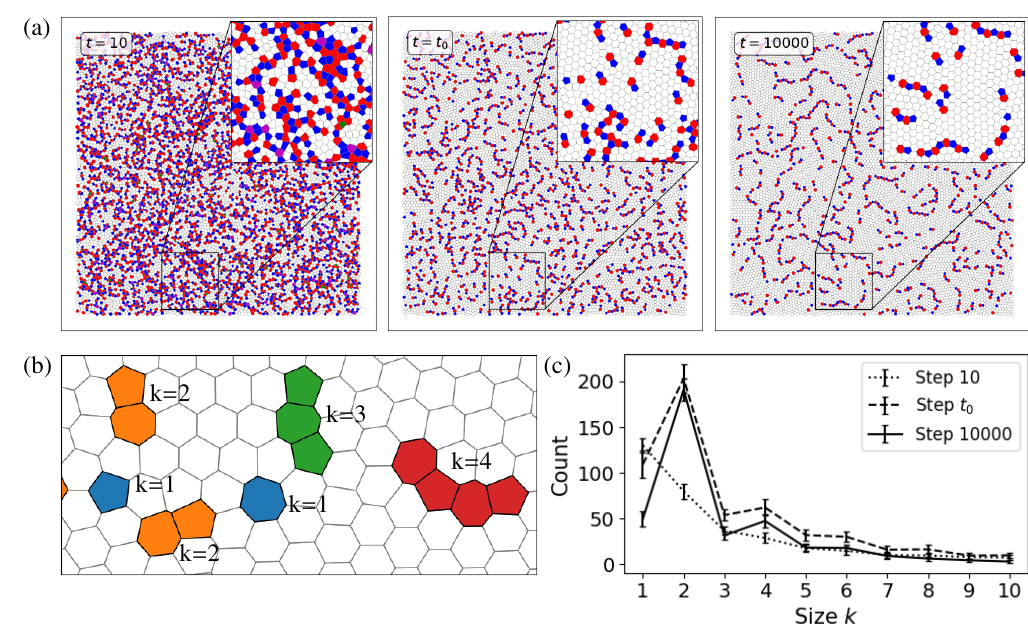
Figure 2: (a) Voronoi landscapes of an evolving Poisson-PP at Lloyd steps t = 10 , t 0 and 10 4 (from left to right), where cells are coloured according to the number of their edges; in particular, pentagons and heptagons are highlighted in blue and red, respectively, while hexagons are white. The inset shows a zoom-in window for the same selected area in each snapshot. (b) An illustration of defect components in di ff erent colours according to their size k , captured in a local area of the rightmost configuration in (a). (c) The number of defect components of size k for k ≤ 10 at the selected iteration steps, averaged over 20 realisations at each of the corresponding steps. The errorbar indicates the standard error of the